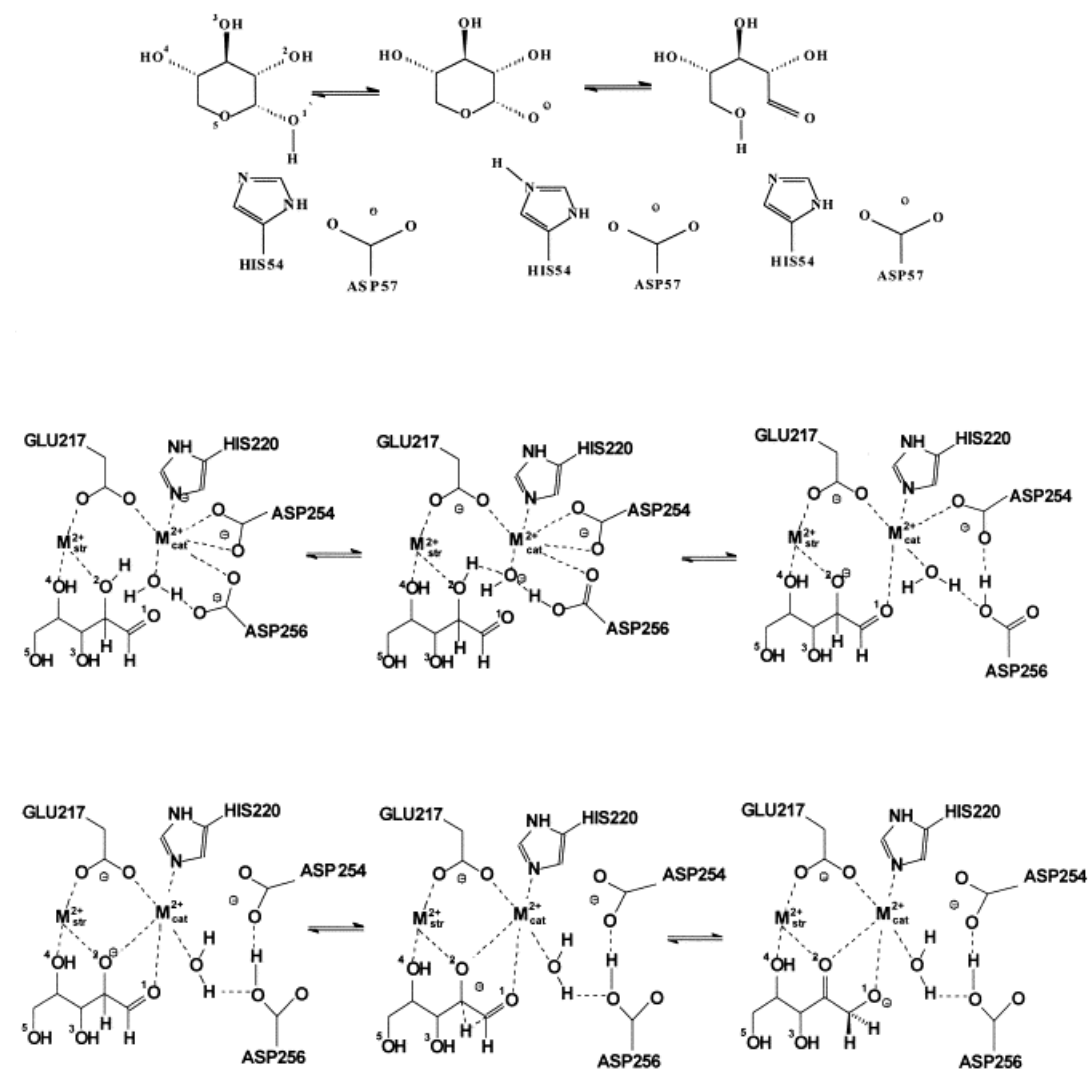
Figure 19. Catalytic mechanism of xylose isomerase . Top: ring opening, middle: substrate deprotonation, bottom: hydride